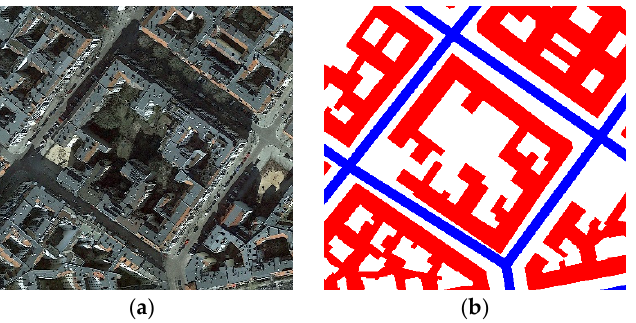
Figure 1. Test set images of dataset I: ( a )true-color, ( b )ground-truth maps.